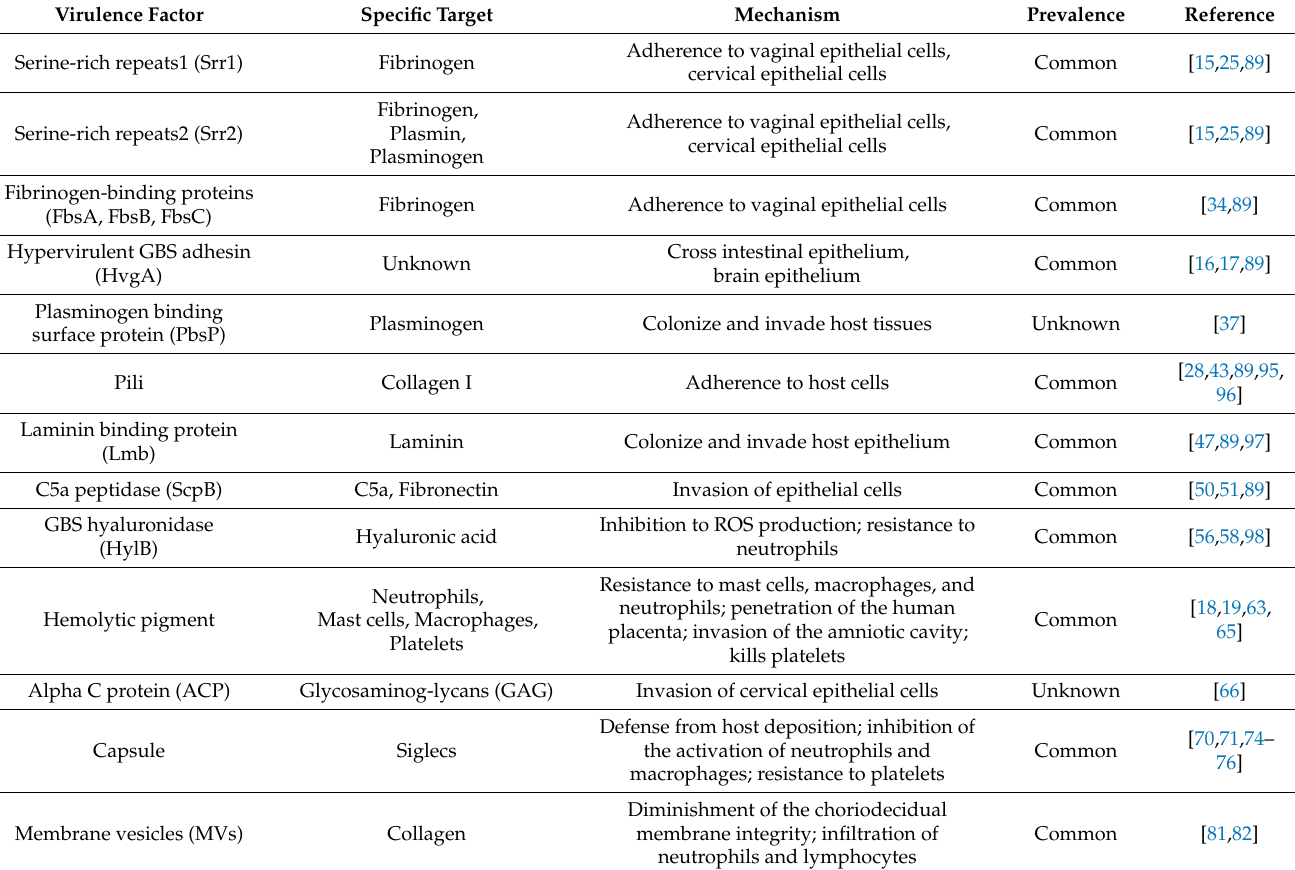
Table 2. Summary of GBS virulence factors covered in this review, with their prevalence, specific targets, and